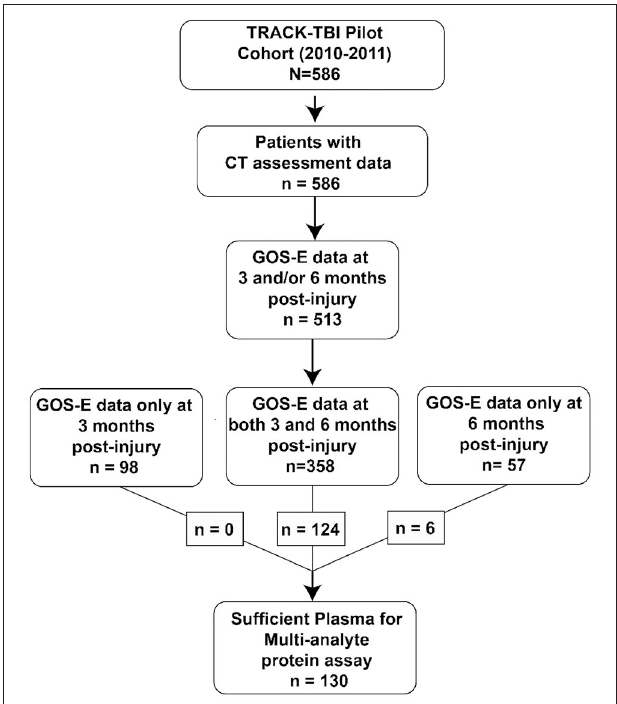
FIGURE 1 | Patient selection. Flow diagram of the subset of patients from the TRACK-TBI Pilot dataset that was reused in the current set of